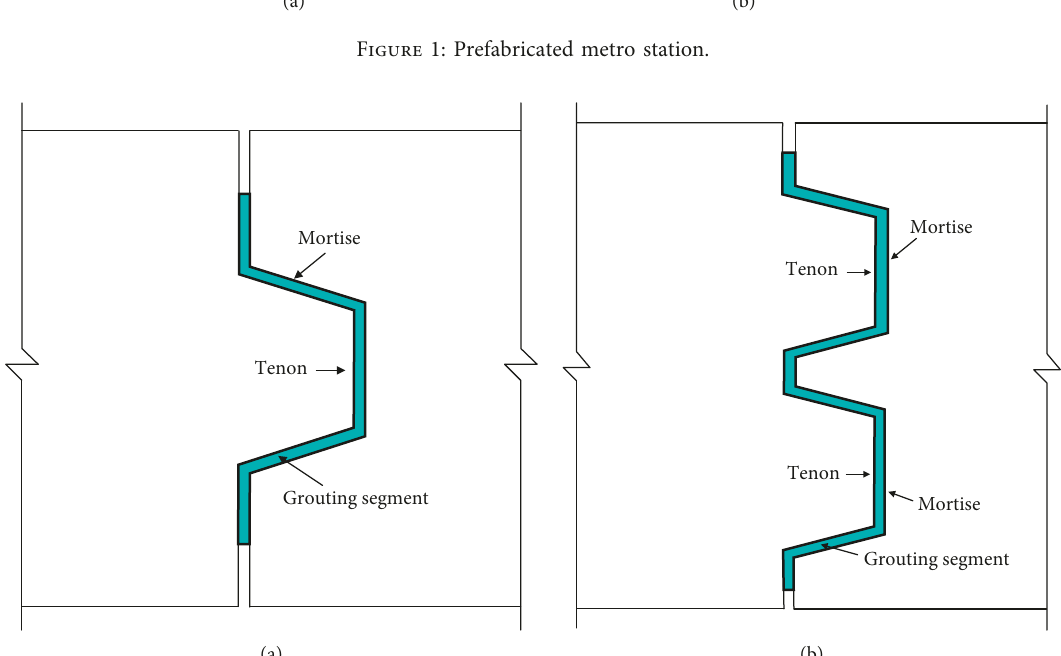
Figure 2: The MT · G-Joint used on Changchun Metro Line 2. (a) Single tenon. (b) Double